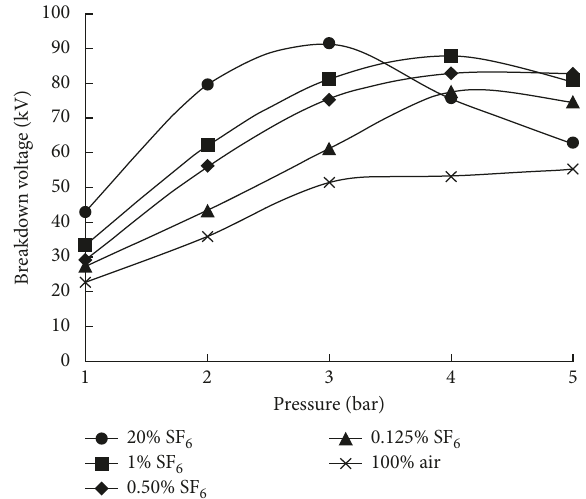
Figure 3: Changing of breakdown voltage with gas pressure for SF 6 -air